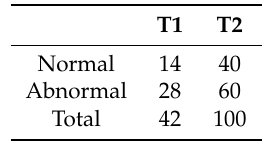
Table 1. The number of T1-weighted and T2-weighted